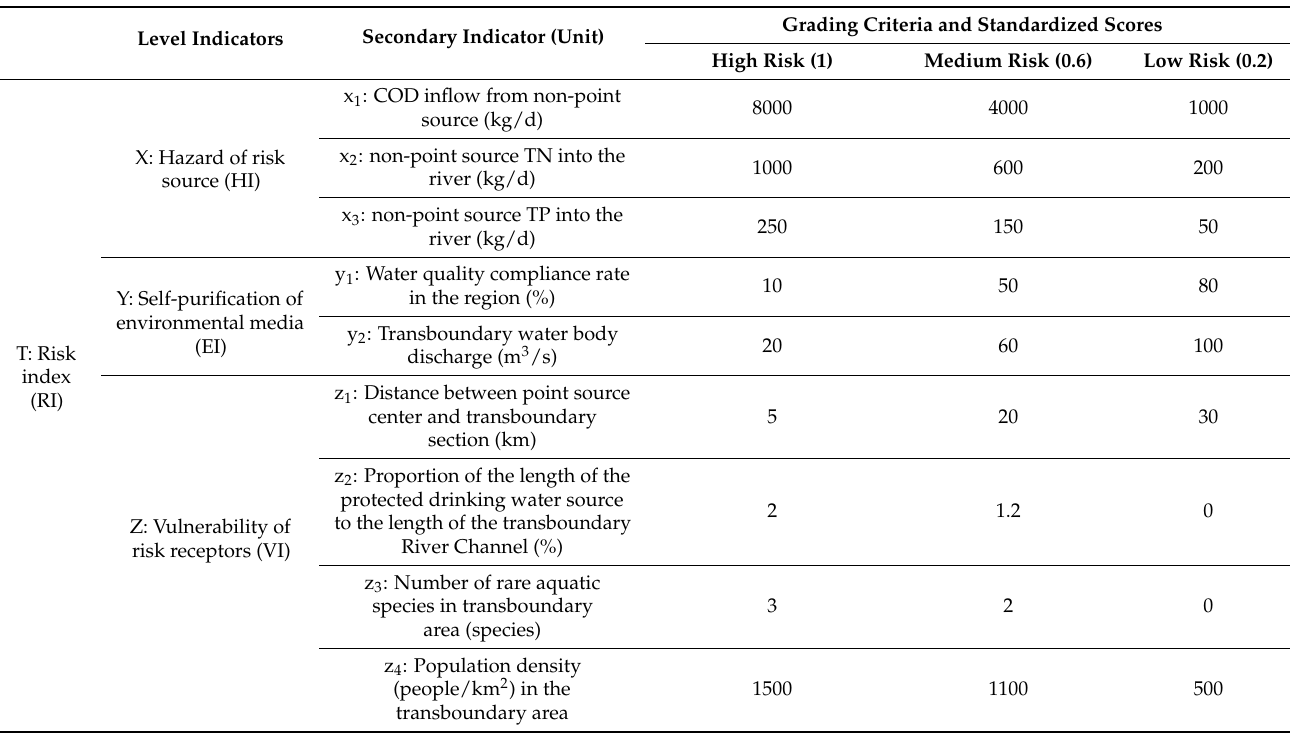
Table 3. Risk assessment index system for non-point sources in cross-border